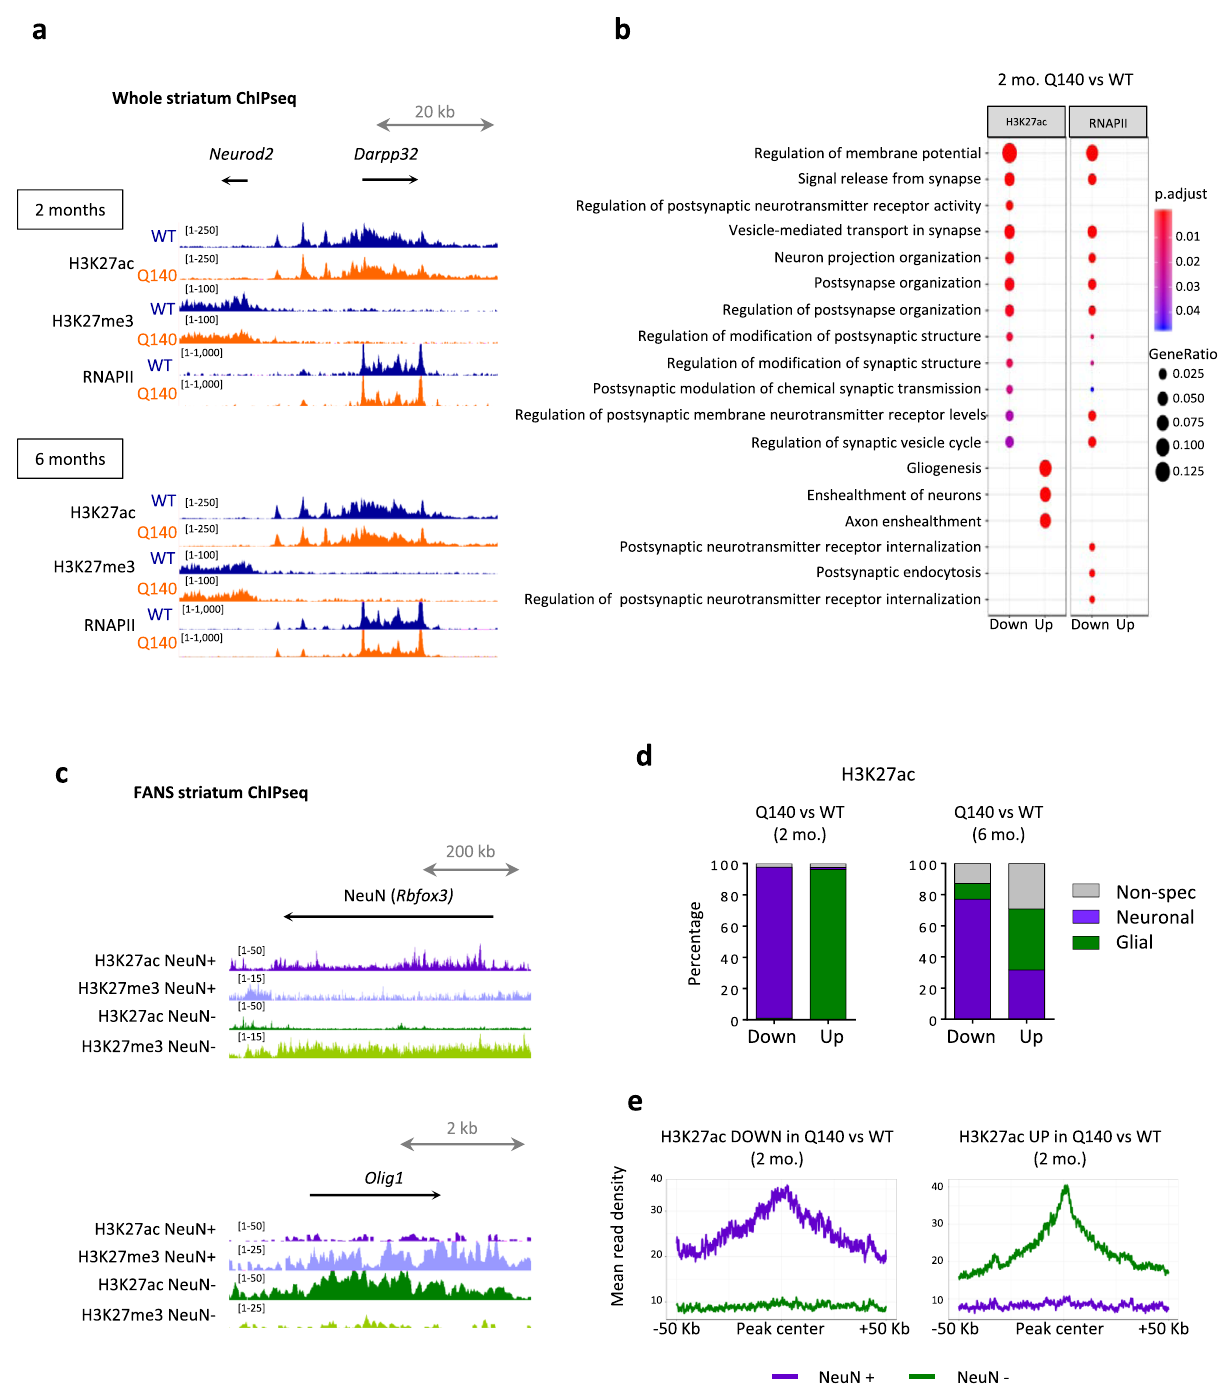
Fig. 1 Striatal epigenetic alterations induced by the HD mutation establish early and in cell-type-dependent manner in HD Q140 mice. a UCSC genome browser capture showing representative H3K27ac, H3K27me3 and RNAPII signals in the striatum of WT and Q140 mouse striatum at 2 and 6 months at selected locus, including active ( Darpp32 ( Ppp1r1b )) and repressed ( Neurod2 ) genes in the adult striatum. 2 mo., 2 months; 6 mo., 6 months b Gene Ontology analysis of regions differentially enriched in H3K27ac and RNAPII between Q140 and WT mouse striatal samples at 2 months (FDR < 0.05). Signi fi cant biological processes are shown using dot size proportional to gene ratio and heatmap re fl ecting adjusted P value. c UCSC genome browser capture showing representative H3K27ac and H3K27me3 signals in striatal NeuN + and NeuN − populations in WT mice at 6 months at selected neuronal gene ( NeuN ( Rbfox3 )) and glial gene ( Olig2 ). d Bargraphs showing cell-type distribution of regions differentially enriched in H3K27ac in Q140 vs WT mouse striatum at 2 and 6 months of age. e Metapro fi les showing H3K27ac signal in NeuN + and NeuN − sorted nuclei, considering differentially enriched peaks in Q140 vs WT striata at 2 months. Source data are provided as a Source Data fi le.